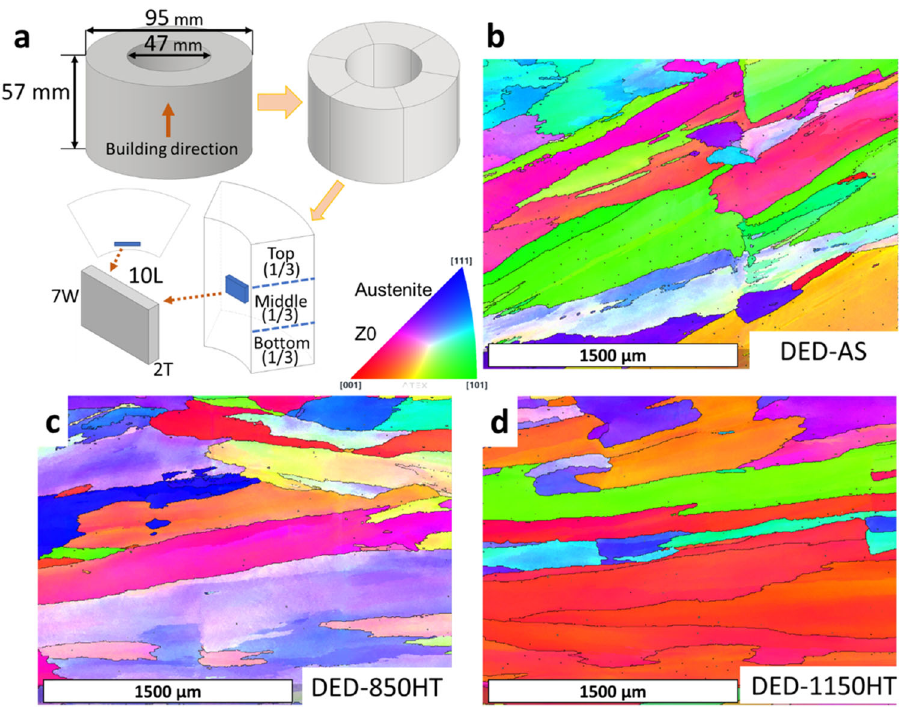
Fig. 1 Schematic of DED 316L SS hollow cylinder with sampling scheme, and EBSD results. a Schematic of DED 316L SS hollow cylinder with sampling scheme, and b – d grain orientation maps of the as-manufacture and heat-treated DED 316L SS. The building direction of EBSD maps is from left to right.